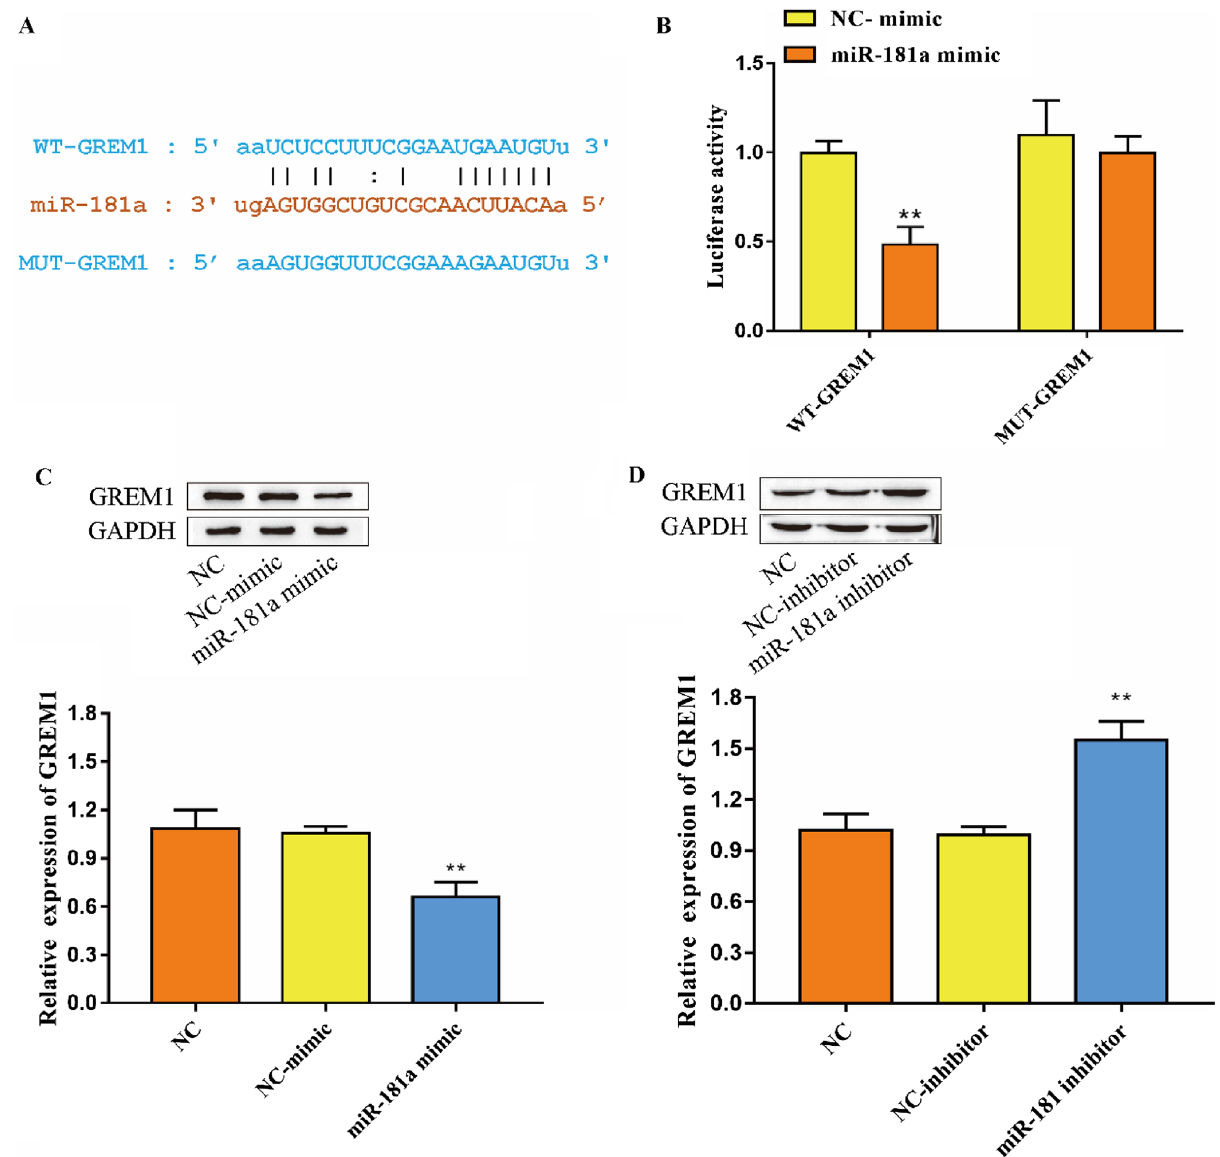
Figure 5. Validation of the targeting relationship between GREM1 and miR-181a ( A ) GREM1 and miR-181a binding sequence; ( B ) Dual-luciferase reporter system to verify the binding of GREM1 and miR-181a sequence; ( C ) Western blot detection of the expression level of GREM1; ( D ) Western blot detection of the expression level of